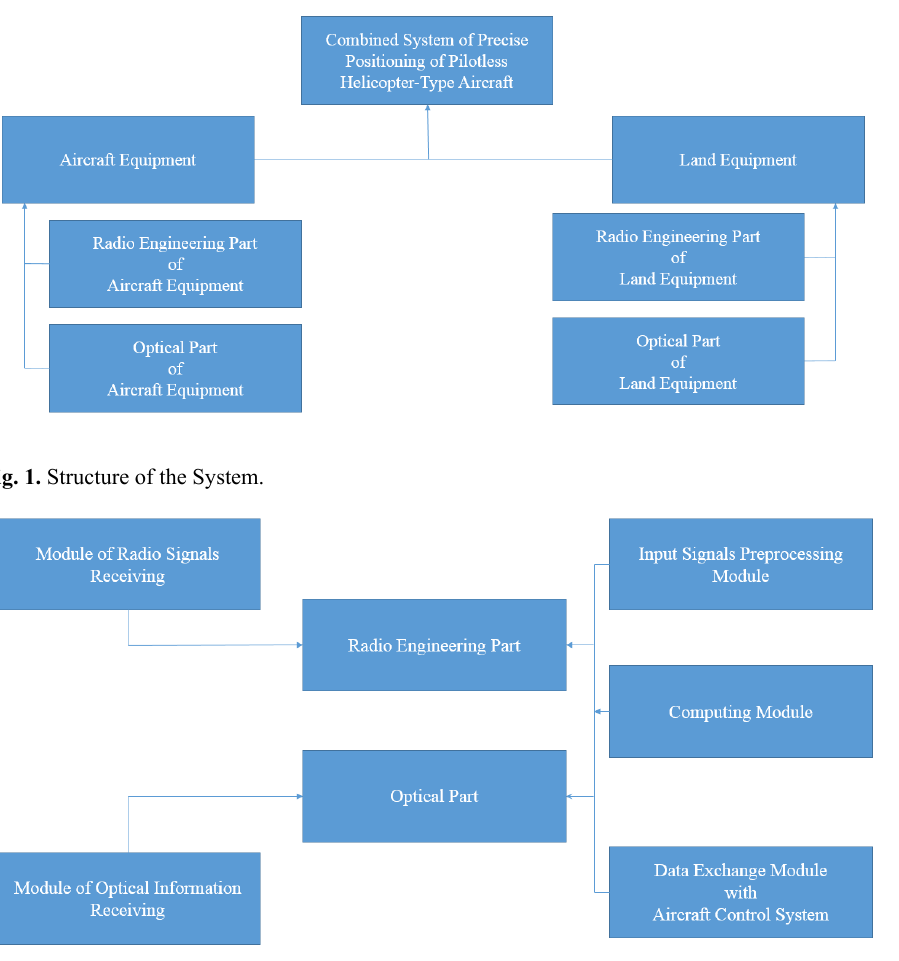
Fig. 2. Structure of the Onboard